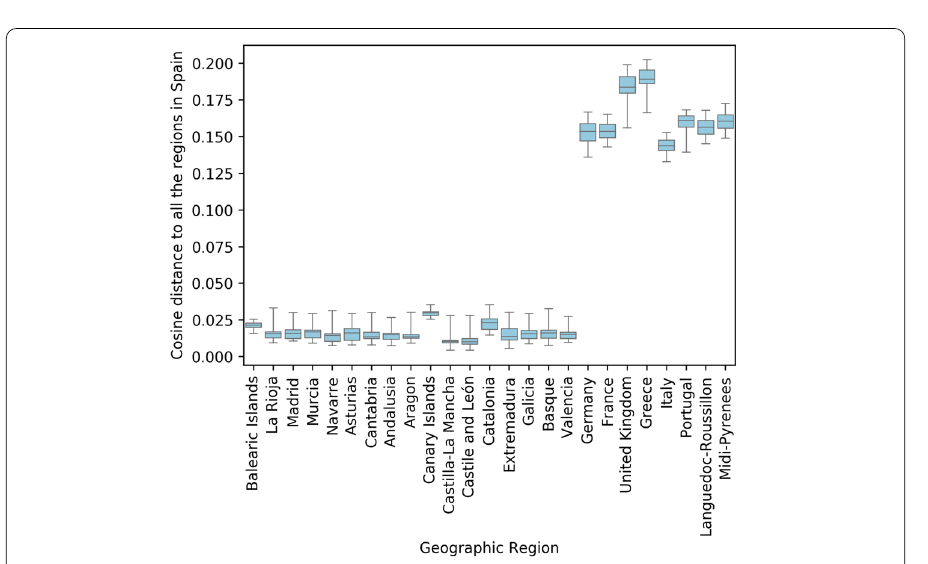
Figure 3 Cosine distance measurement between Spanish CCAAs and different geographic